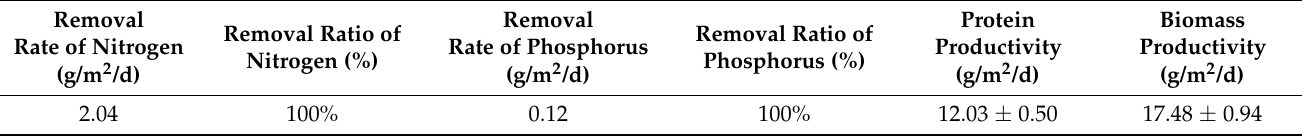
Table 6. N, P removal rate and removal ratio, biomass and protein productivities of Arthrospira platensis cultivated in a circular